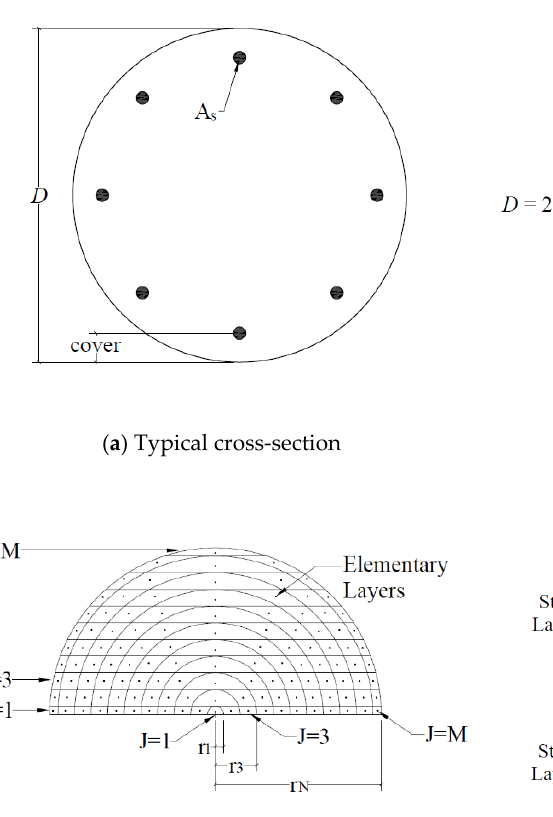
Figure 4. Geometry and meshing of rectangular sections.